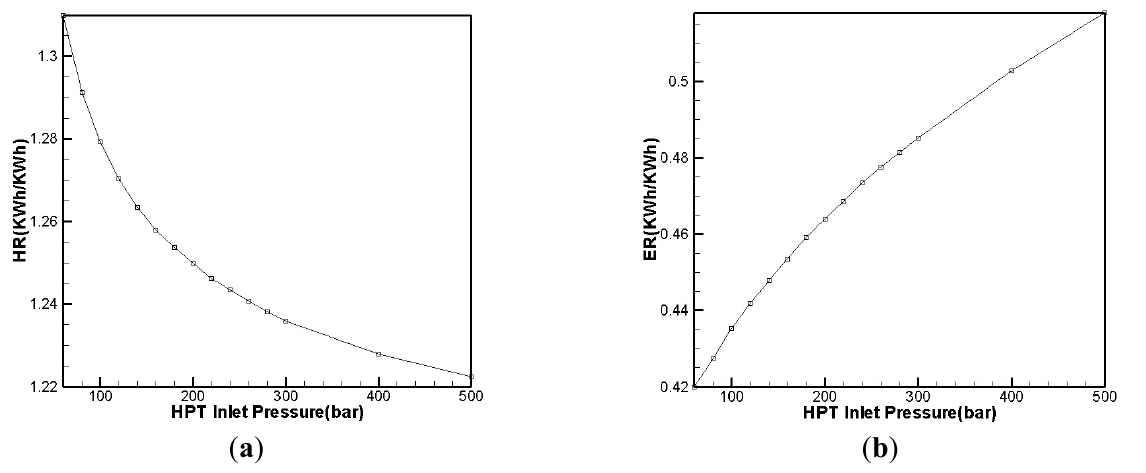
Figure 8. Effects of HPT inlet pressure on ( a ) heat rate (HR); ( b ) electric power consumption rate